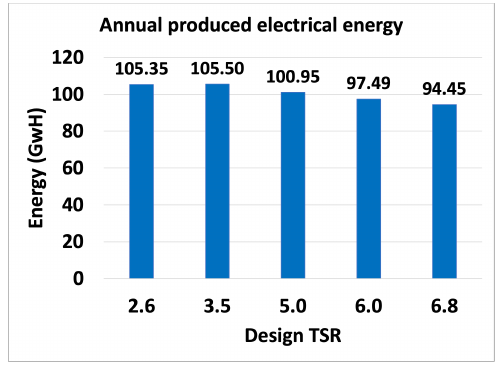
Fig. 29. Full scale turbine: annual electrical energy production. Design solutions for λ des from 2.6 to 6.8